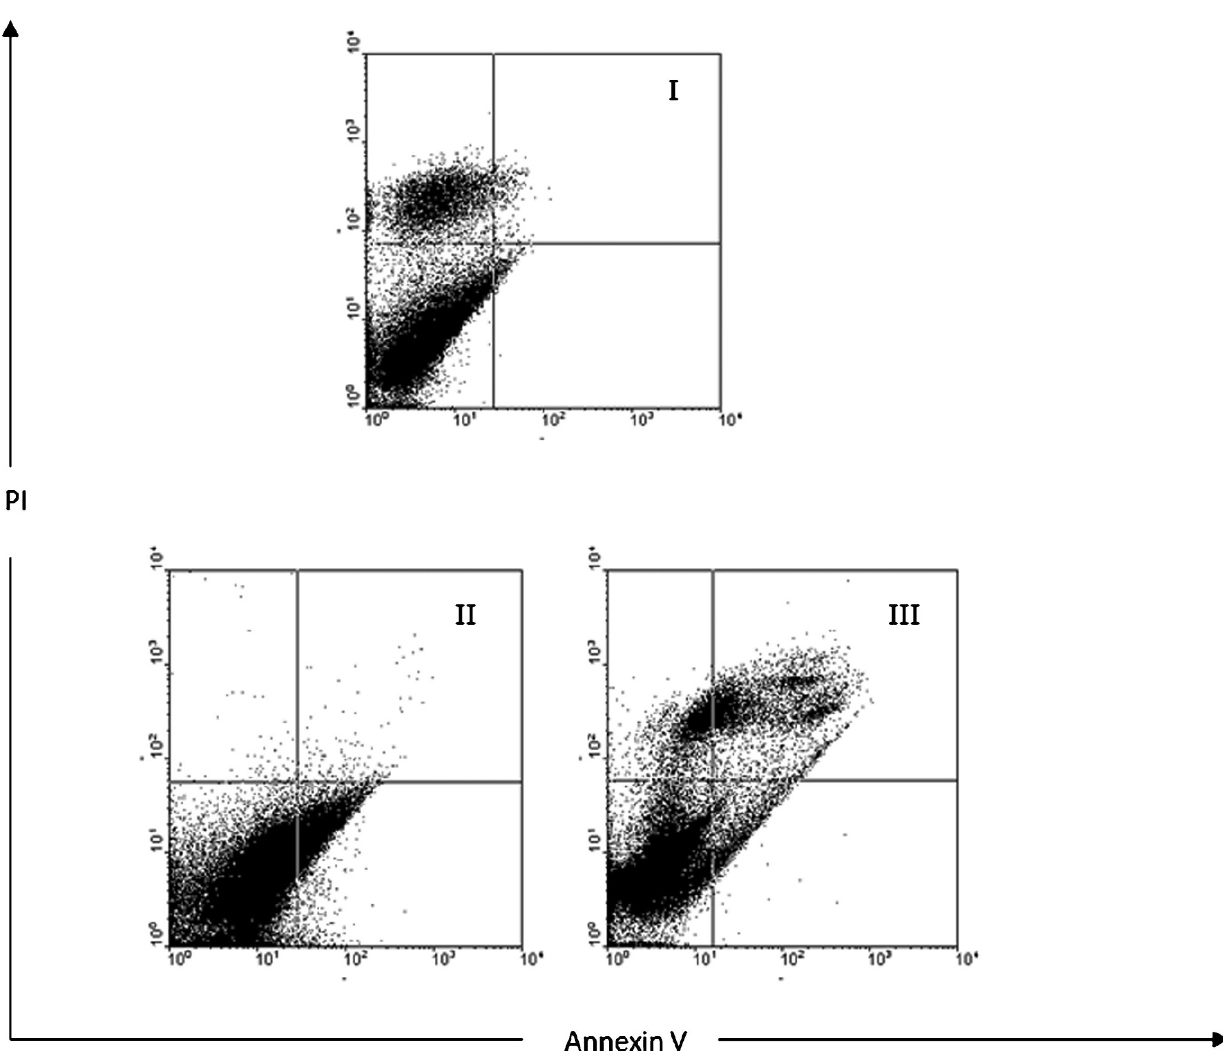
Figure 4 - Assessment of apoptosis by Annexin V/PI on human prostate cancer cells (PC-3). The cells were treated with 10 and 40 m M chrysin for 48 h (symbol P , PI ) or media only (control symbol I ), and apoptosis was examined by flow cytometry after Annexin V-PI double staining. Necrotic cells lose membrane integrity, permitting PI entry. Viable cells exhibit Annexin V (-)/PI (-); early apoptotic cells exhibit Annexin ( + )/PI (-); late apoptotic cells or necrotic cells exhibit Annexin V ( + )/PI ( +